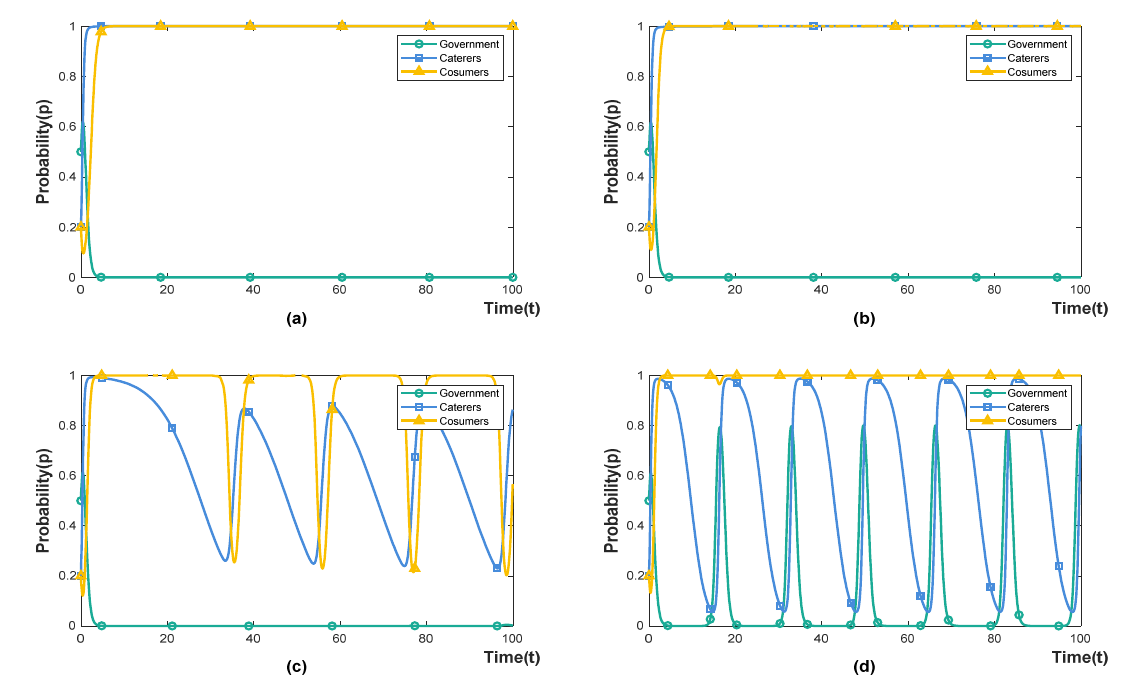
Figure 6. The effect of ε on the evolution trajectory. ( a ) ε = 0.2. ( b ) ε = 0.4. ( c ) ε = 0.6. ( d ) ε = 0.8 .